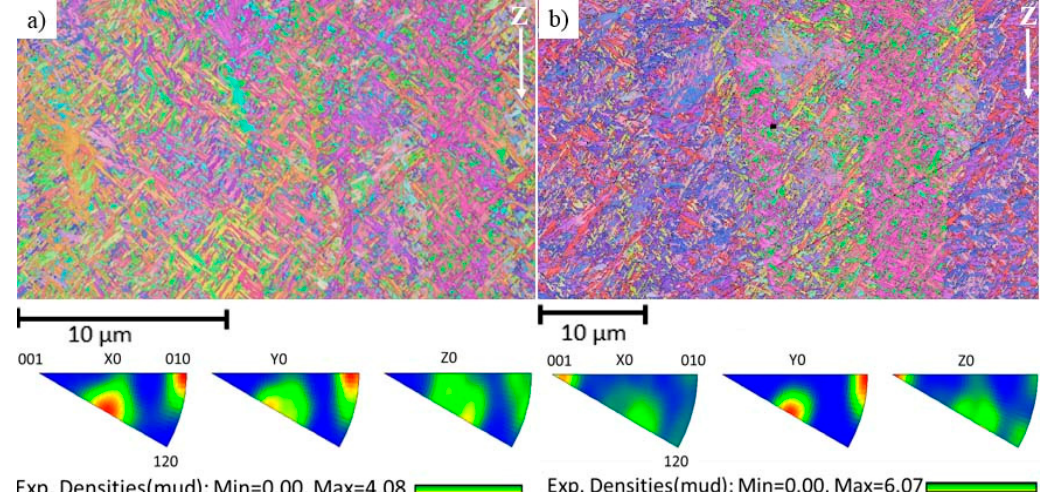
Figure 4. Inverse pole figure maps of Ti-6Al-4V (S7V). The build direction is indicated by the white arrows. ( a ) is close to the last layer; ( b ) few mm below from ( a ); Images under (a,b) is the corresponding inverse pole figures.